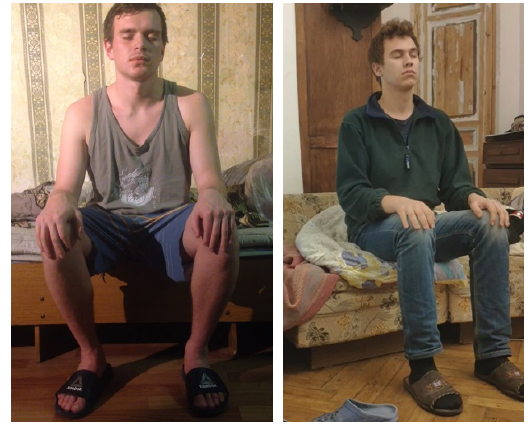
Figure 10. Dataset example: beginner in sitting position.